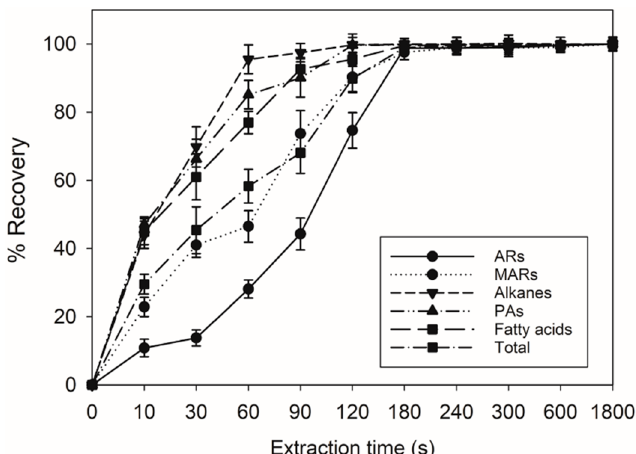
Figure 1. Recovery of total lipids and individual lipid components by chloroform extracting of the wheat seed surface. ARs, n -alkylresorcinols; MARs, n -methylalkylresorcinols; PAs, primary alcohols. Data points are expressed as the mean ± SD of four biological replicates.